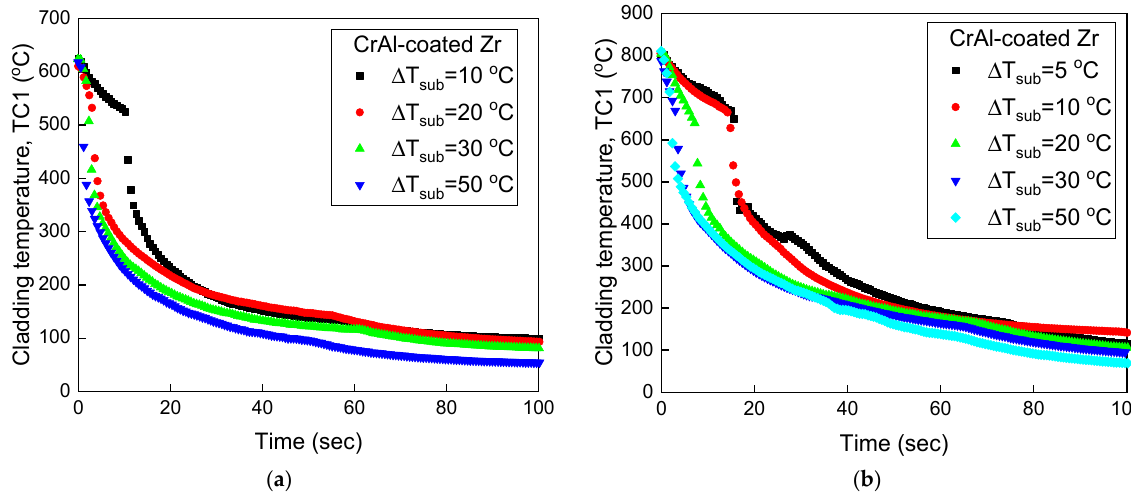
Figure 14. Effect of coolant subcooling for the CrAl-coated Zr quenching at; ( a ) Tw = 600 °C; ( b ) Tw = 800 °C.